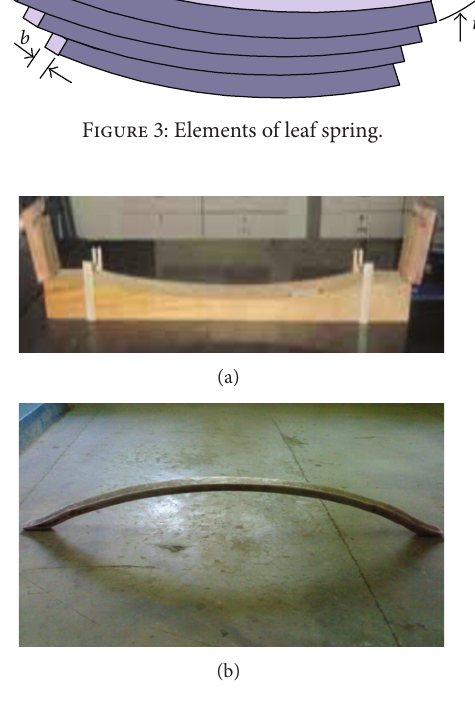
Figure 4: (a) Configuration of the pattern. (b) A monocomposite leaf spring.